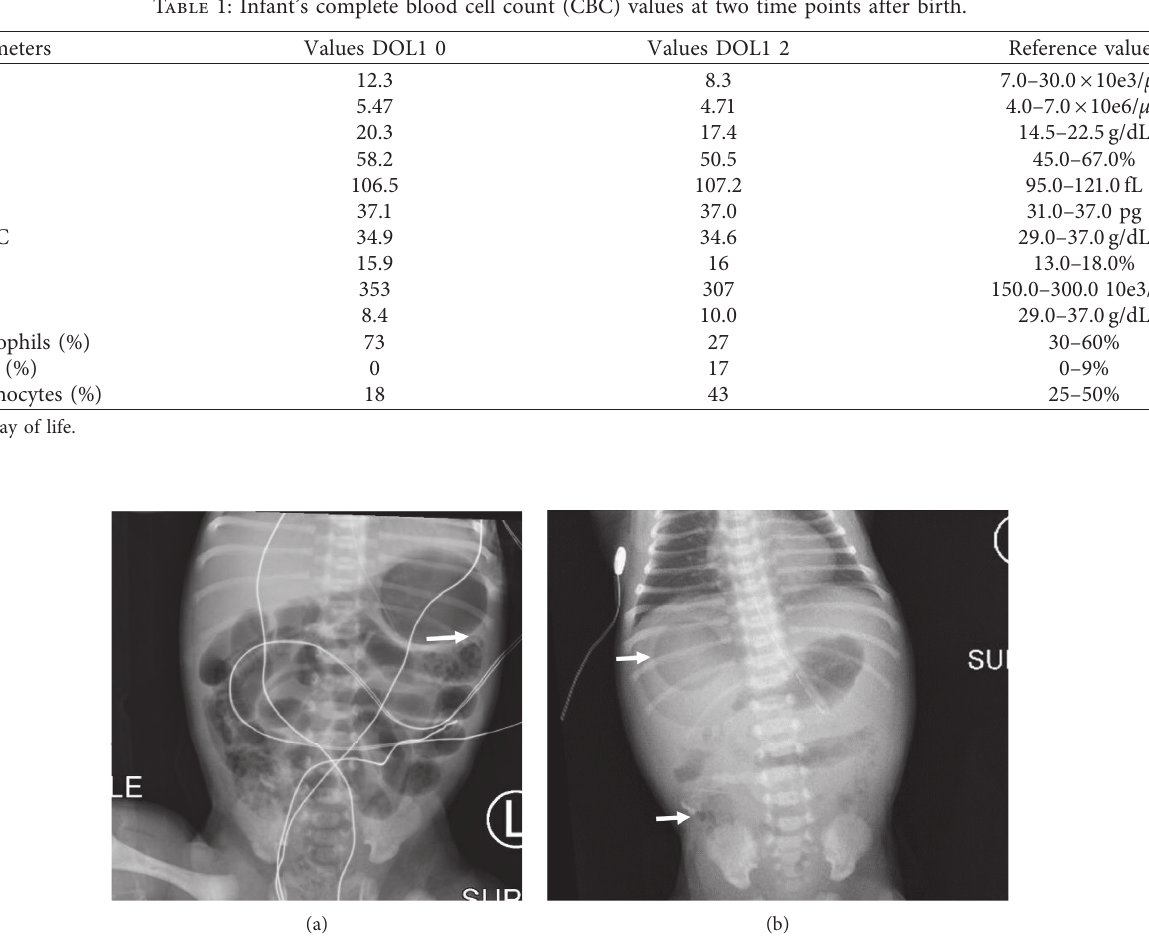
Figure 1: Abdominal x-rays of the premature infant. (a) Image obtained at 30 h of age. Arrow indicates the area of pneumatosis intestinalis. (b) Image obtained at 36h of age. Upper arrow points to one area of pneumoperitoneum, and the lower arrow points to an area of pneumatosis intestinalis.